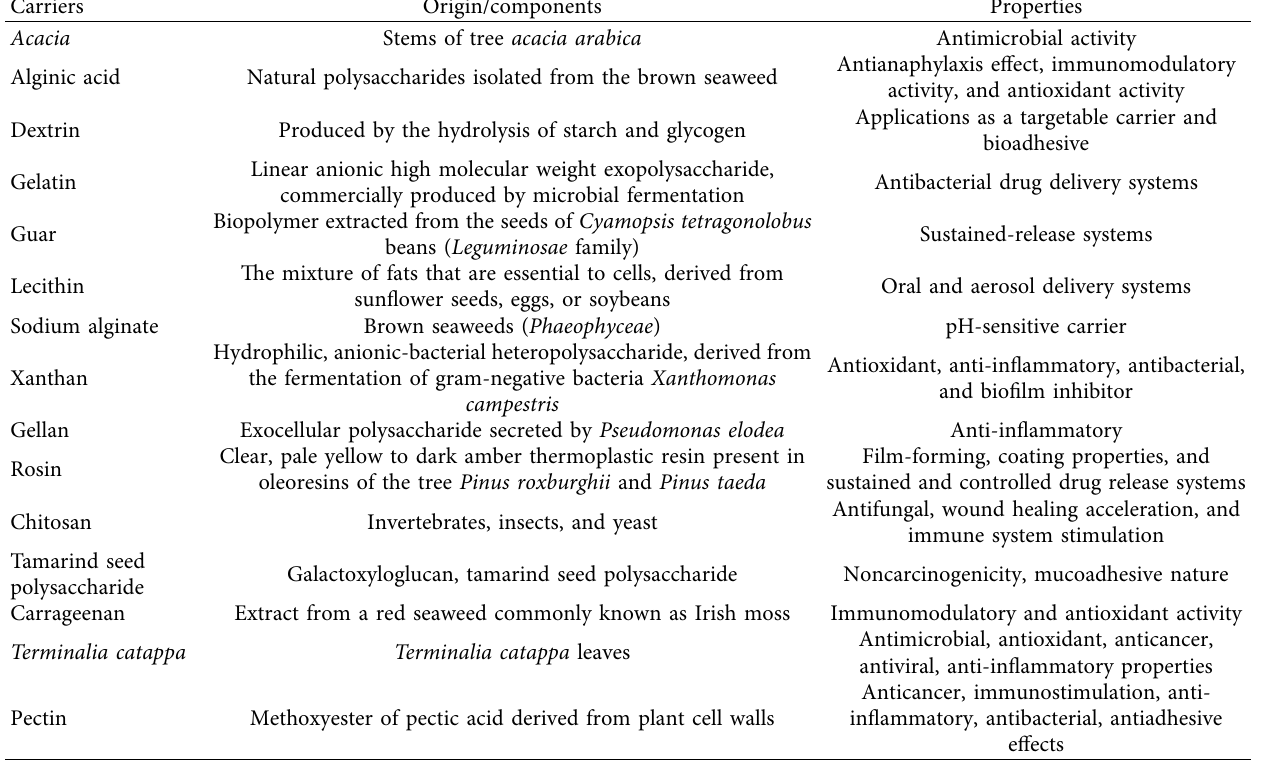
Table 1: Carriers that can be used in chewing gum and their properties.